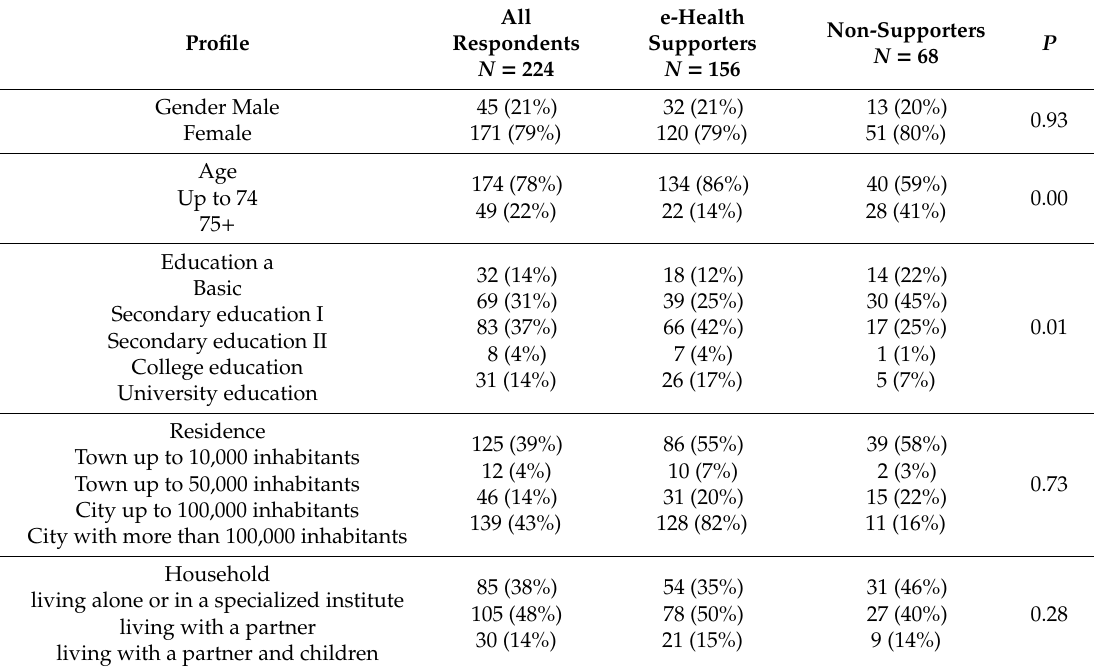
Table 2. Demographic profiles of the e-Health supporters and the non-supporters. Profile